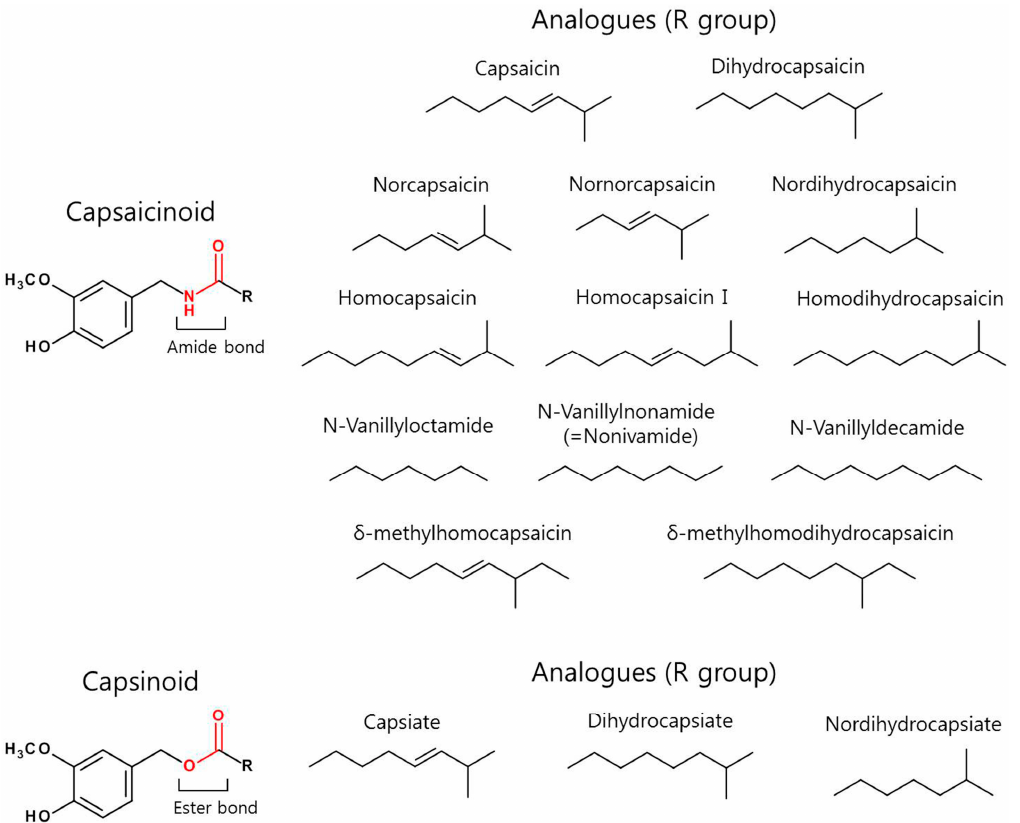
Figure 2. The general chemical structure of capsaicinoid and capsinoid and their related analogues that differ in the R-group are summarized. Capsaicinoids and capsinoids have a common vanillyl moiety and differ in the central linkage (shown in red) and R-group.